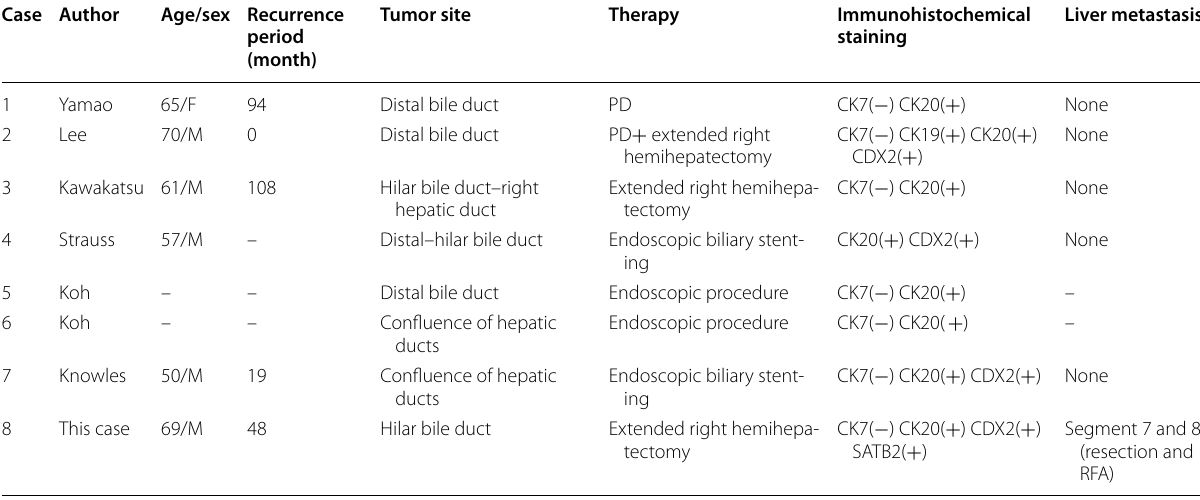
Table 1 Summary of reported cases of bile duct metastasis from colon cancer Case